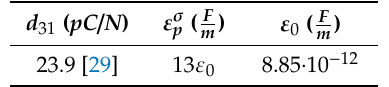
Figure 3. ( a ) Undulating plate in wake flow; ( b ) pure bending of the plate; ( c ) concept of the undulating piezoelectric energy harvester. Table 3. Properties of piezoelectric PVDF.